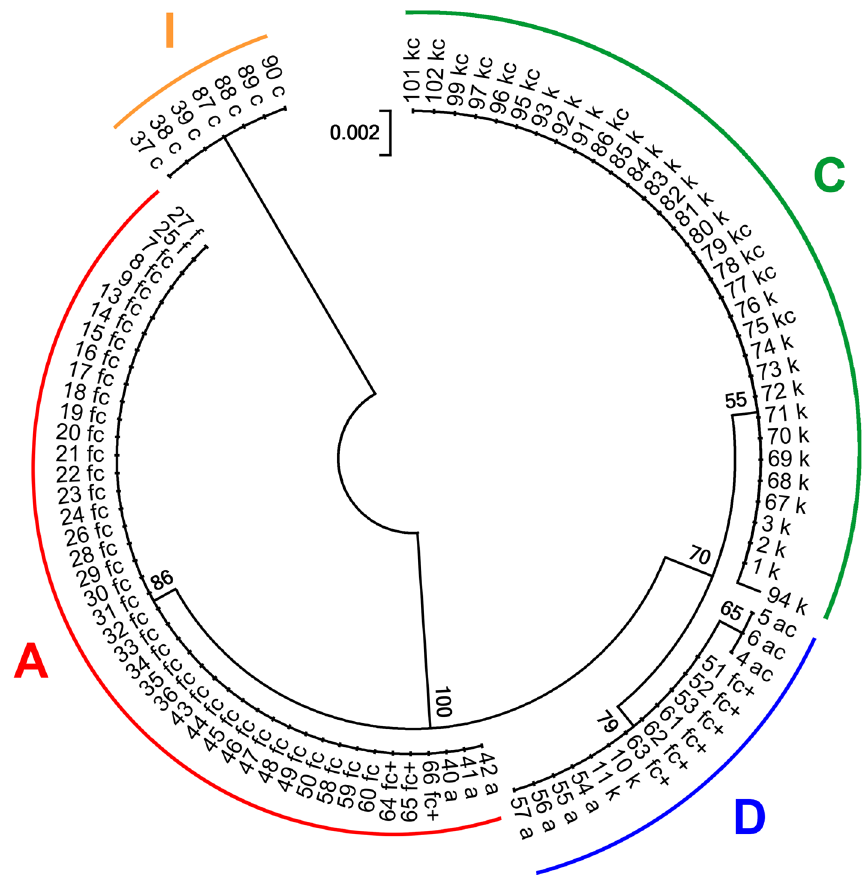
Figure 3. Phylogenetic relations within Batrachium studied samples based on the rpl32-trnL region. Numbers correspond to sample numbers in Supplementary data: Table S1. Haplotypes according to Bobrov et al. 11 ; see also Tables S1, S3. Bootstrap support values from 1000 replicates are shown next to the